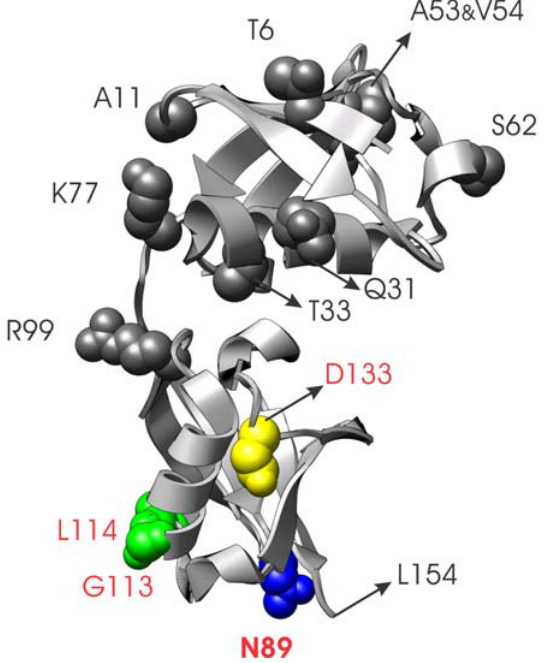
Figure 4. Crystal structure of HuISG15 with indication of the residues different in AgmISG15. Residues that differ between HuISG15 and AgmISG15 are shown as space filing spheres. Colored residues are dissimilar residues situated in or near the interaction site with UbE1L predicted by Narasimhan et al. [35].